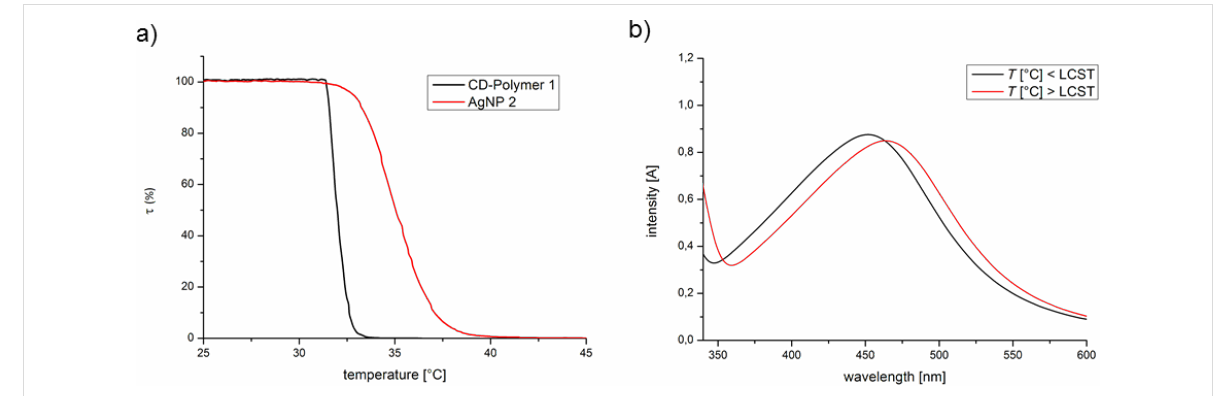
Figure 4: a) Turbity meseaurments of 2a ; b) UV–vis absorption spectra of 2a below and upon its LCST.